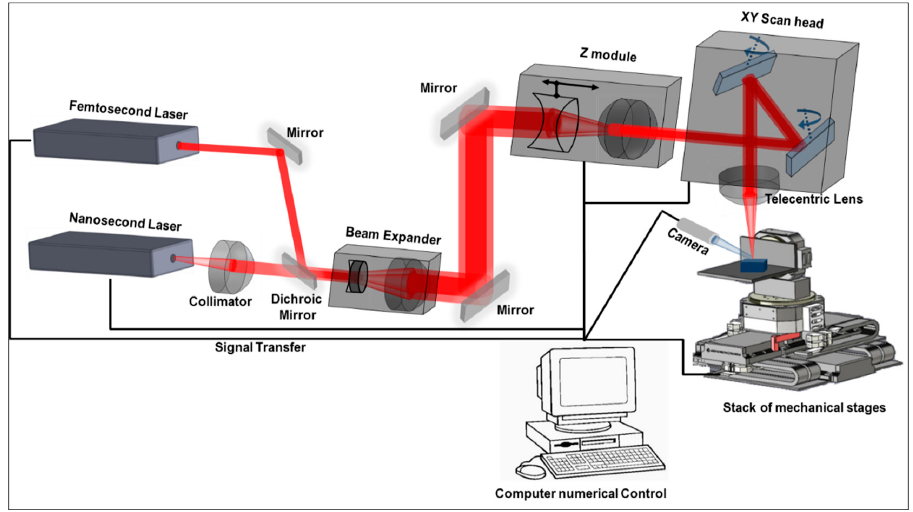
Figure 1. Schematic representation of the laser microprocessing platform.